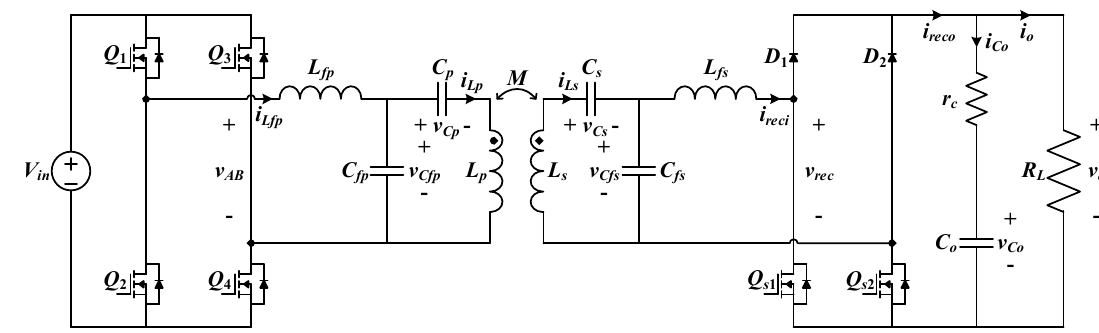
Figure 1. Double-sided Inductor-Capacitor-Capacitor (LCC) compensation topology with S-BAR.